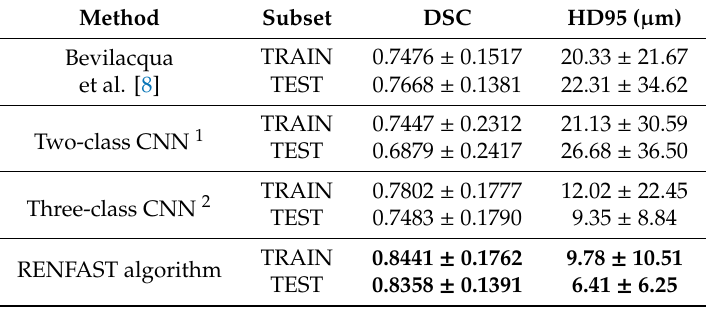
Table 3. Object-based metrics calculated on detected blood vessels for both the TRAIN and TEST